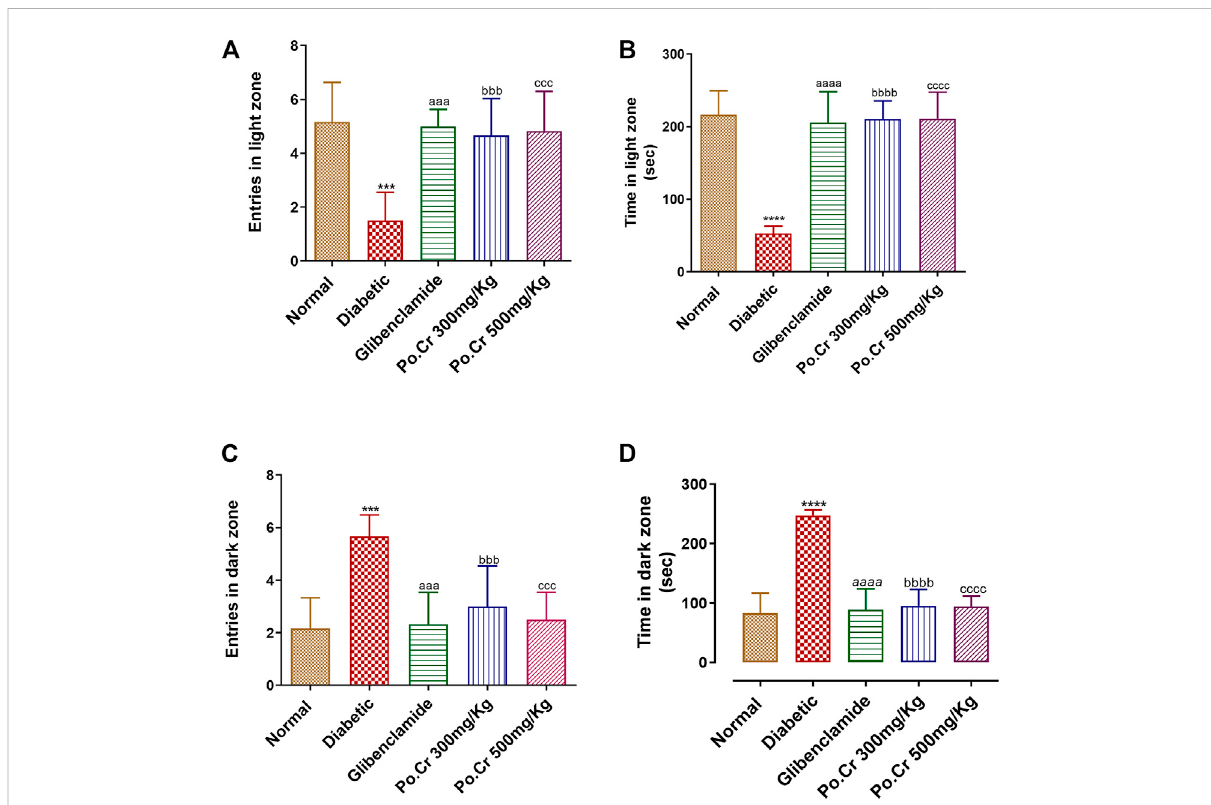
FIGURE 5 Anxiolytic effects of Po.Cr on alloxan-induced diabetic rats in the light and dark (L/D) test. (A) Entries into the light zone. (B) Time spent in the light zone. (C) Entries into the dark zone. (D) Time spent in the dark zone. Group II (diabetic control) was compared to Group I (normal control), whereas all the treated groups (Groups III [glibenclamide] to V [Po.Cr]) were compared with Group II (diabetic control). ANOVA (two-way) and the multiple comparison Dunnett ’ s test were applied, and the data values are mean ± SEM. * p < 0.05 indicates comparison of the diabetic control (Group II) to the normal control (Group I), whereas a p < 0.05, b p < 0.05, and c p < 0.05 indicates comparison of glibenclamide (Group III); Po.Cr, 300 mg/kg (Group IV); and Po.Cr, 500 mg/kg (Group V) versus the diabetic control group,